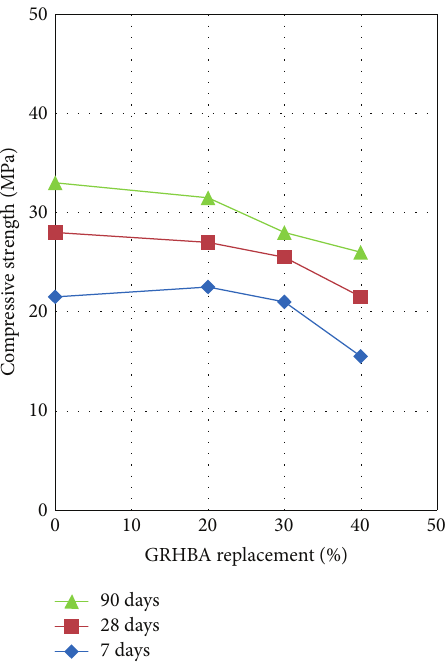
Figure 6: Relationship between compressive strength and % of GRHBA replacement.